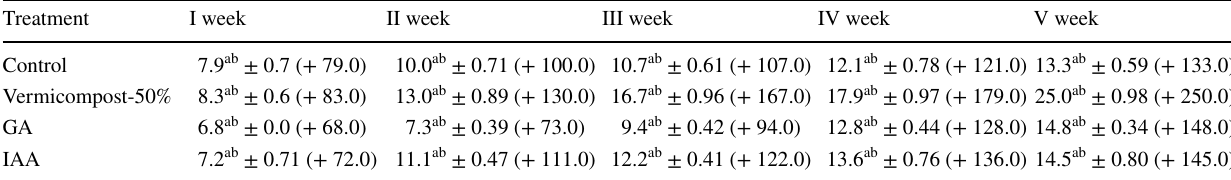
Values are mean ± S.E of10 individual observations. Values in parentheses are percent change over control. Degrees of freedom F ≤ 0.05 a Represents significance of variance between periods b Represents significance of variance